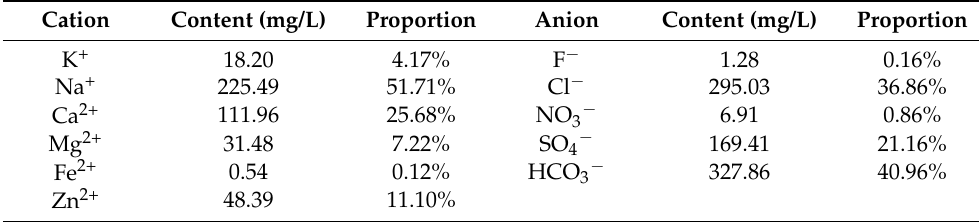
Table 1. Main chemical composition of injected water.